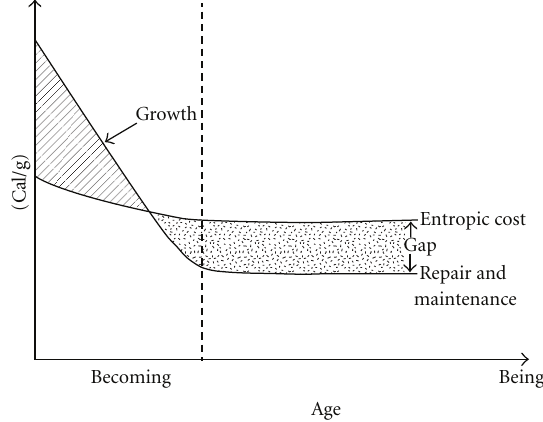
Figure 3: Energetics of a self-organizing system during growth and maturity